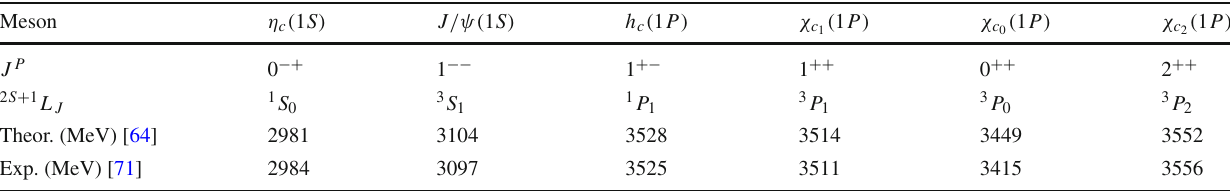
Table 2 Masses of the low-lying S - and P -wave ¯ cc mesons calculated in Ref. [64] Meson